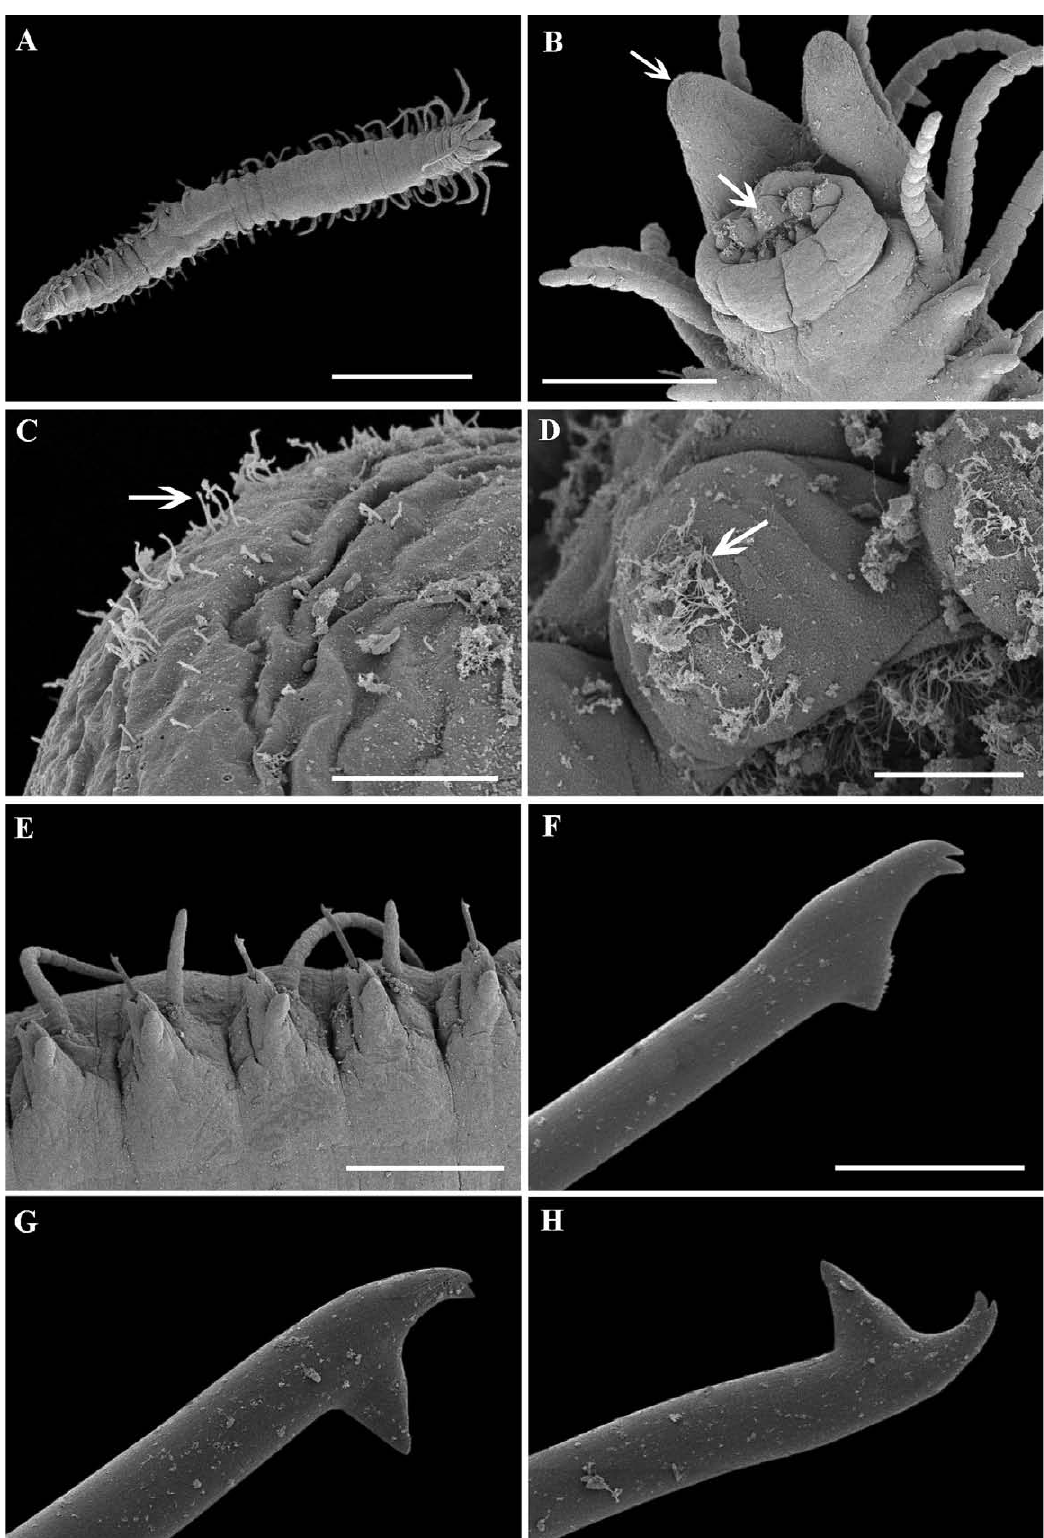
Fig . 16. – SEM micrographs of Haplosyllis niphatesicola n. sp. A, whole body, lateral view. B, anterior end, ventral view, arrows point on cilia on palps and pharyngeal papillae. C, detail of cilia on upper side of palps, indicated by arrow. D, detail of cilia on ventral side of pharyngeal papillae, indicated by arrow. E, mid-body parapodia with cirri alternating long and short. F, anterior chaetae, chaetiger 4. G, mid-body chaeta. H, posterior chaeta. Scale bars: A (1 mm); B, E (200 m m); C, F (10 m m); D, G-H (20 m m). INV-ANE